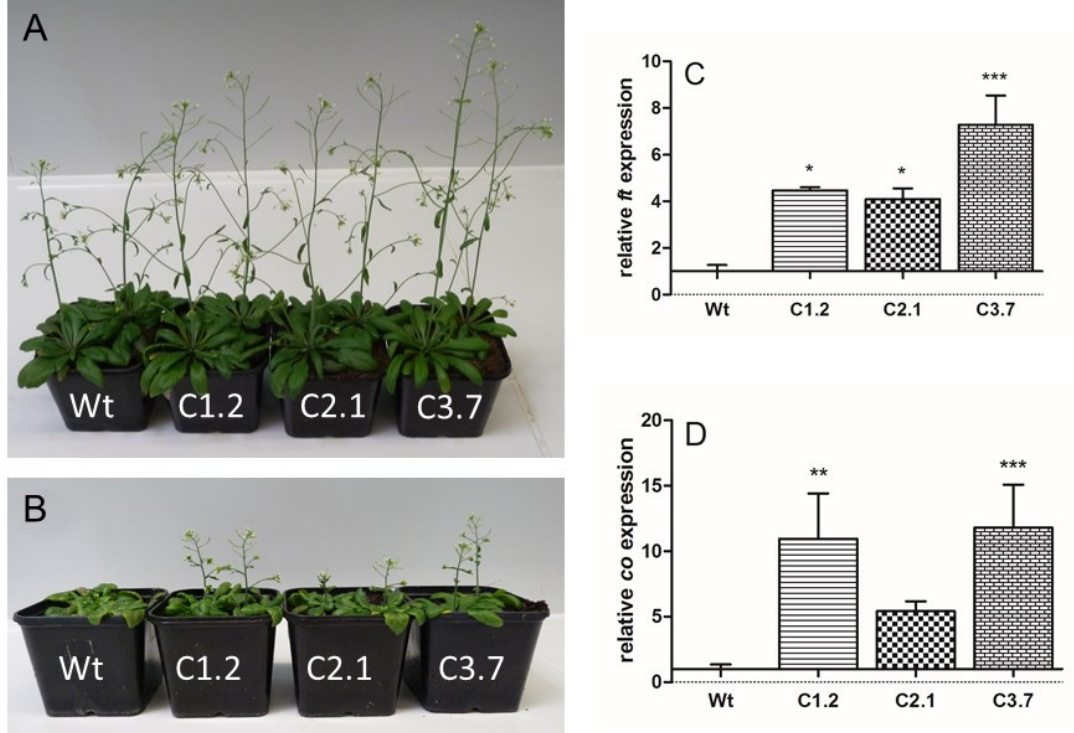
Figure 5. Analysis of plant development on soil of Wt and p35s::SOS1 c-term StrepII mutants. Plants were grown on soil for three weeks prior to transfer to long-day conditions. For the following two weeks, plants were treated with the same volume of either tap water ( A ) or tap water containing 150 mM NaCl ( B ) every three days. Pictures were taken after seven weeks of growth. ( C ) Relative transcript levels of Flowering Locus T in Arabidopsis leaves under salt stress conditions. ( D ) Relative transcript levels of CONSTANS in Arabidopsis leaves under salt stress conditions. Data represent means of three independent biological replicates, +/- SE. Data with *** are significant from Wt at p < 0.001, data with ** are significant from Wt at p < 0.01 and data with * are significant from Wt at p < 0.05 (two-way ANOVA) Data are normalized to the housekeeping gene pp2a ( At1g13320 ).